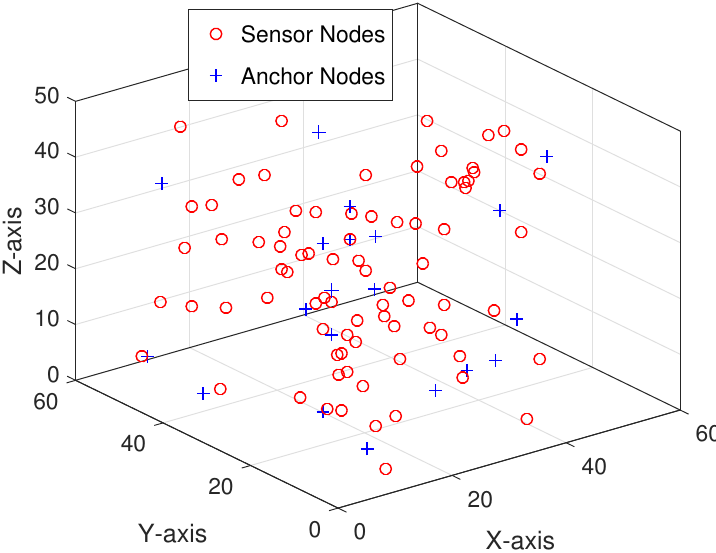
Figure 7. Simulation topology snapshot ( n = 80, m = 20).